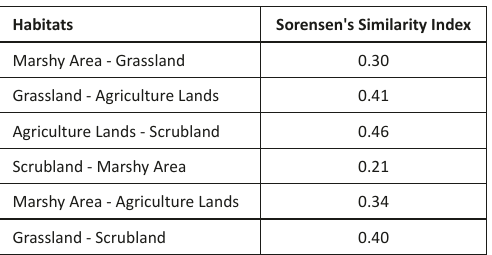
Table 5. Correlation coefficient values for birds species richness in different habitats of Manjeera Wildlife Sanctuary, Andhra Pradesh,